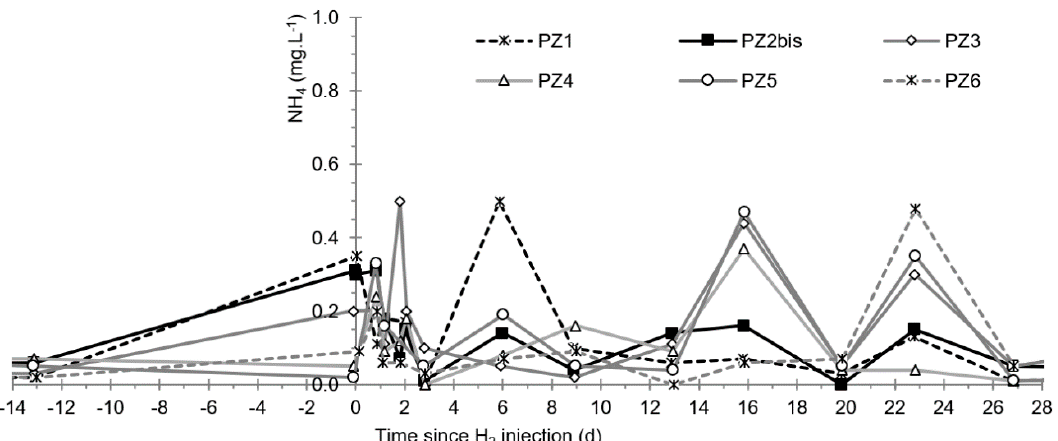
Figure 27. Comparative evolution of the ammonium ion concentrations at all piezometers before and during the dissolved hydrogen injection experiment.